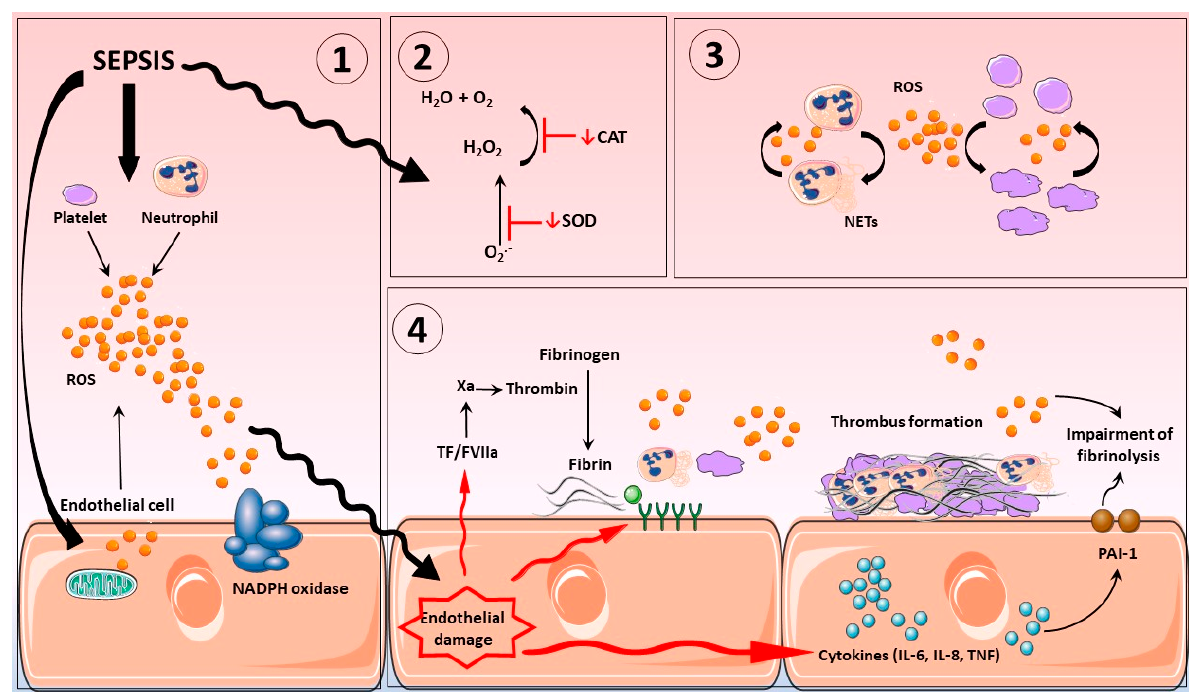
Figure 1. Sepsis induces oxidative stress and disseminates intravascular coagulation. ( 1 ). Sepsis in- duces ROS release by platelets, neutrophils, and endothelial cells. The majority of excessive ROS